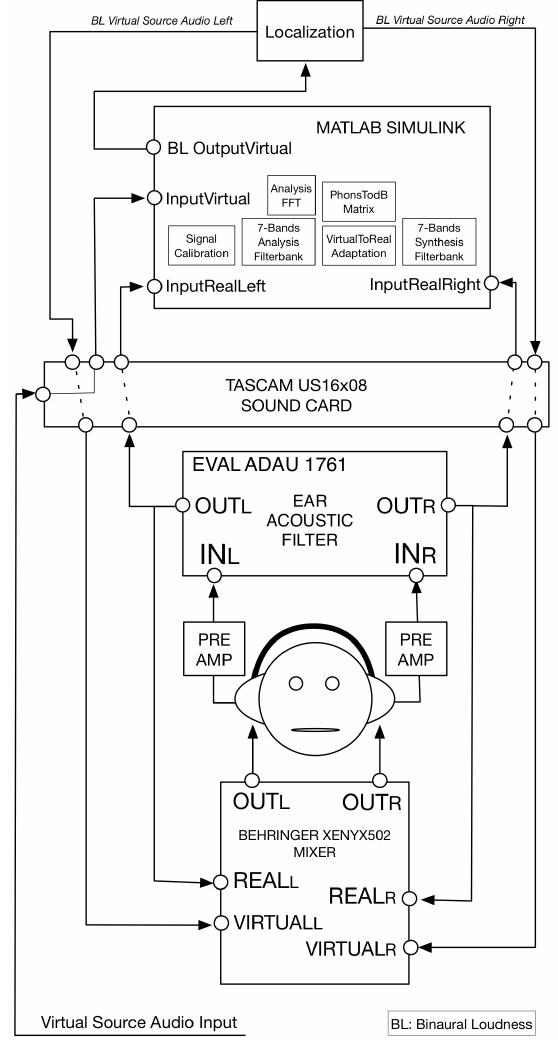
Figure 9. This figure presents the implementation overview.